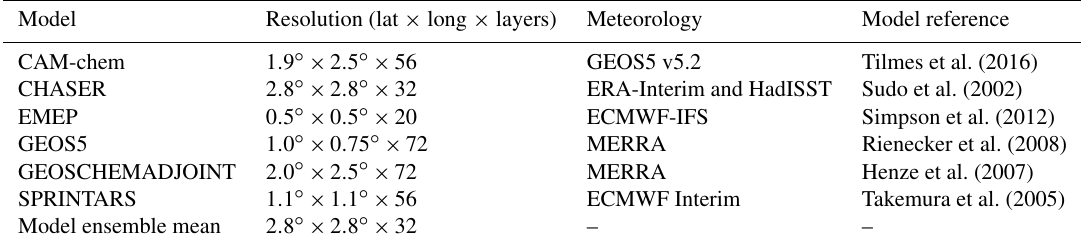
Figure 1. The HTAP2 source and receptor regions for EUR (green), RBU (red), and EAS (grey). Sites marked with the same symbols are from the same observation network: red circles represent API, blue squares represent AERONET, orange diamonds represent EANET, and yellow triangles represent EBAS. Table 1. Models used for this